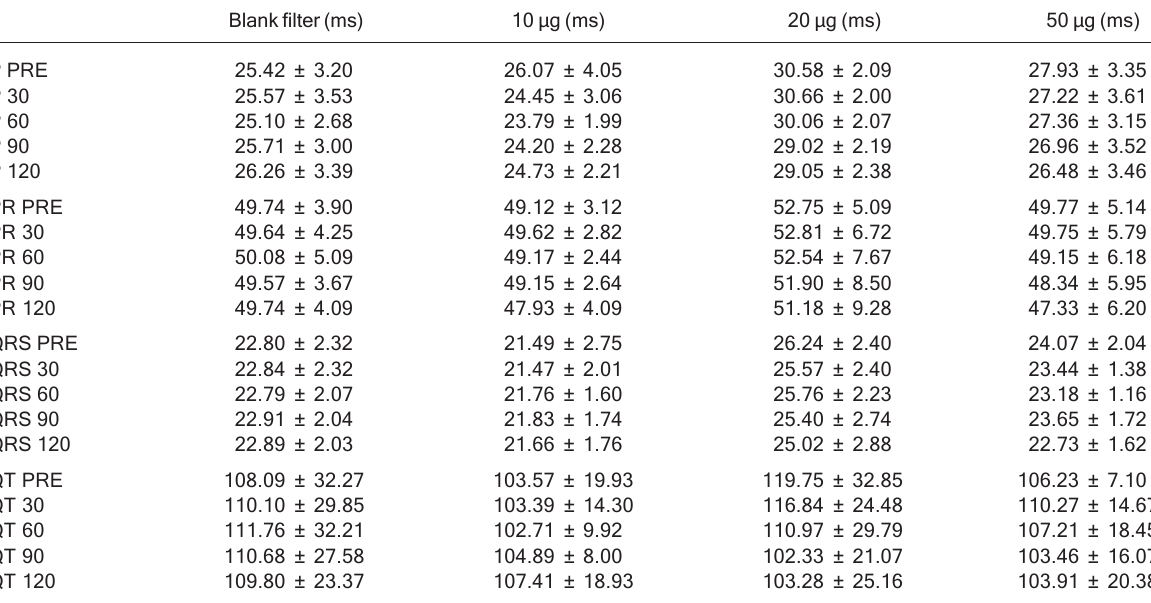
Table 4. Absolute values of each ECG wave segment duration (P, PR, QRS, and QT) for all experimental groups immediately before (PRE) and at 30, 60, 90, and 120 min after tracheal instillation of PM 2.5